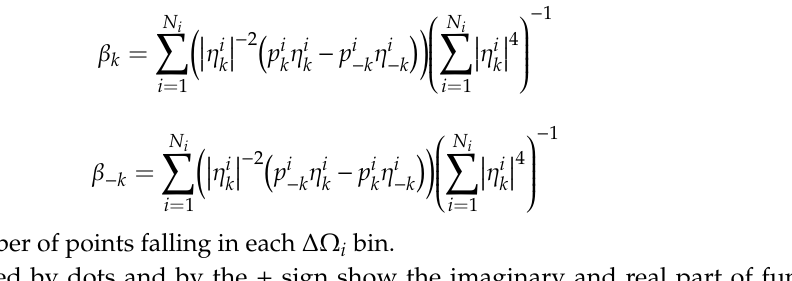
Ω . The filled areas characterize